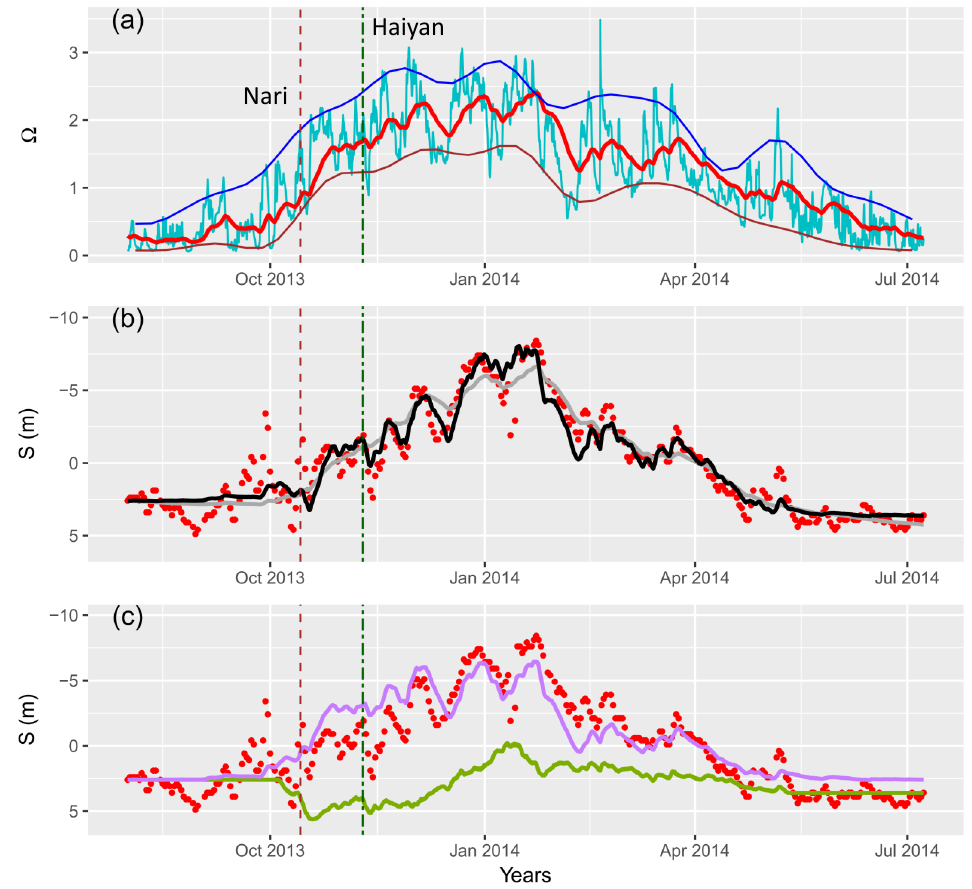
Figure 9. The combined model calibrated with DS 1 . ( a ) Time series of Ω (green line), Ω eq (red line), upper envelope (blue line) and lower envelope (brown line), vertical lines indicate the time of Nari and Haiyan typhoons. ( b ) Time series of measured shoreline position (red points); shoreline position from combined model (black line); shoreline position from ShoreFor model (gray line). ( c ) Cross-shore contribution (purple line) and longshore contribution (green